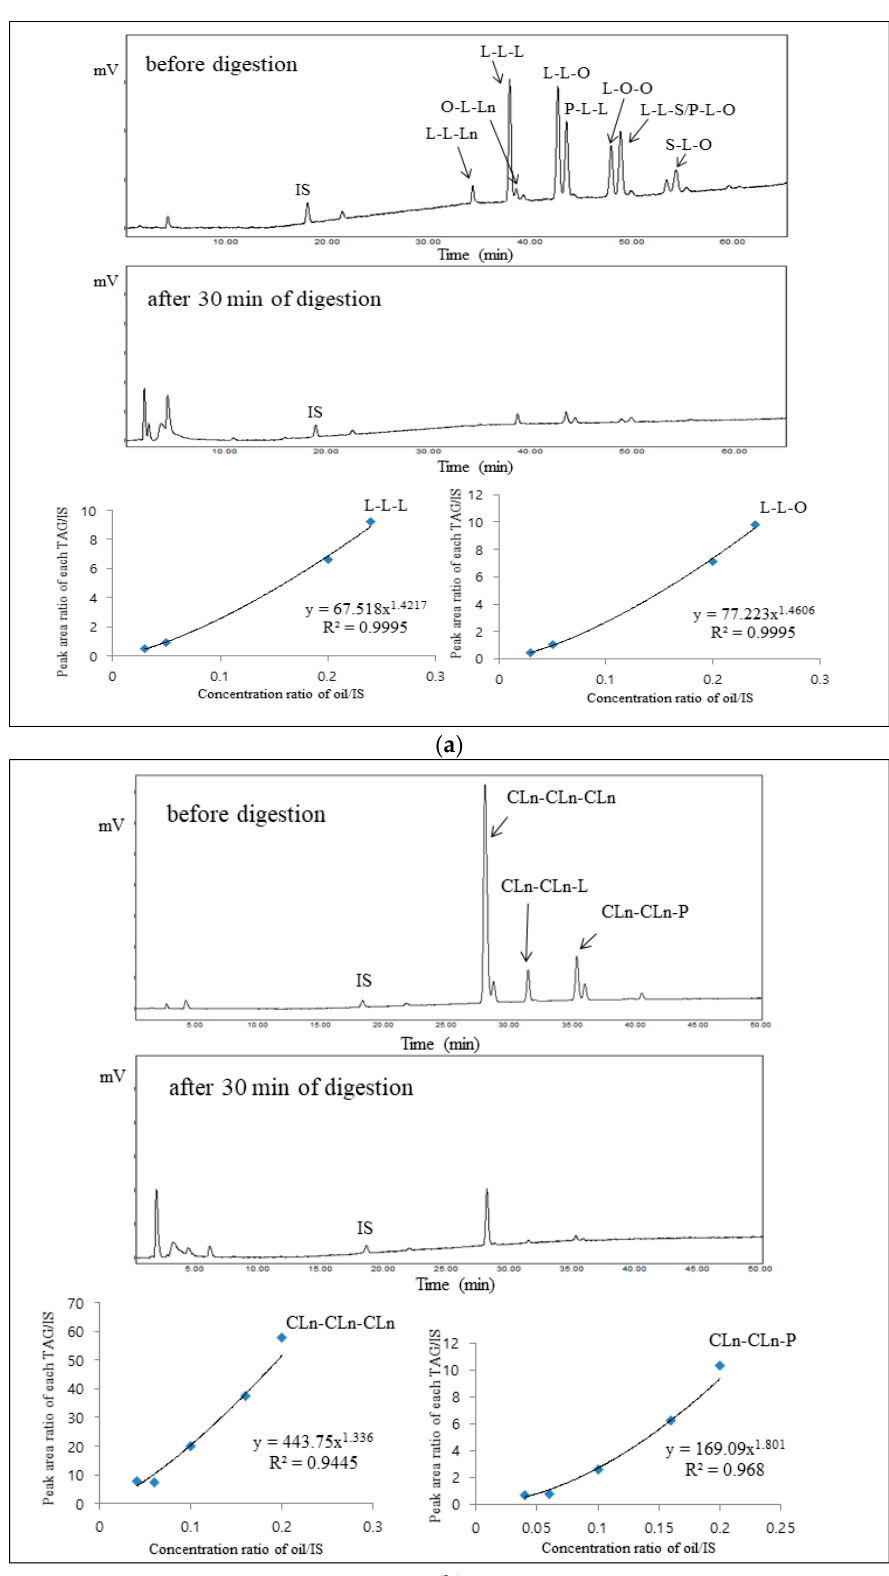
Figure 3. HPLC Chromatograms of soybean oil ( a ) and pomegranate seed oil ( b ) before digestion and after 30-min digestion. The calibration curves (concentration ratio of soybean oil/internal standard versus the peak area ratio of individual triacylglycerol species/internal standard) of trilinoleoyl glycerol (L-L-L), dilinoleoyl-oleoyl glycerol (L-L-O), triconjugated linoleonyl glycerol (CLn-CLn-